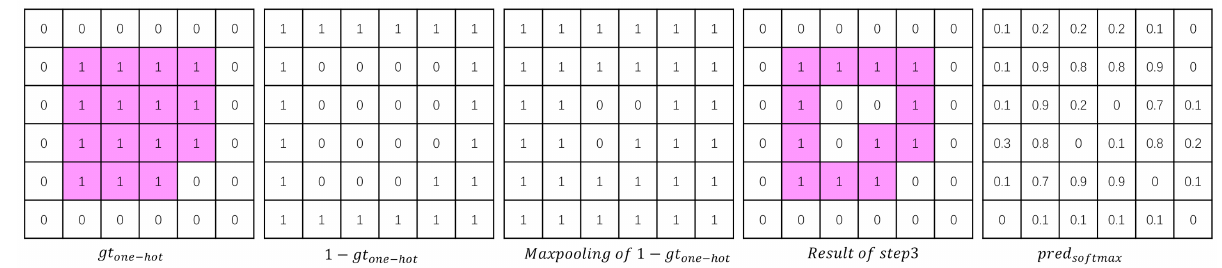
Figure A1. The first four columns are a simple example of obtaining the edge map from a one-hot label, and the last column is an example of the predicted edge probability map.